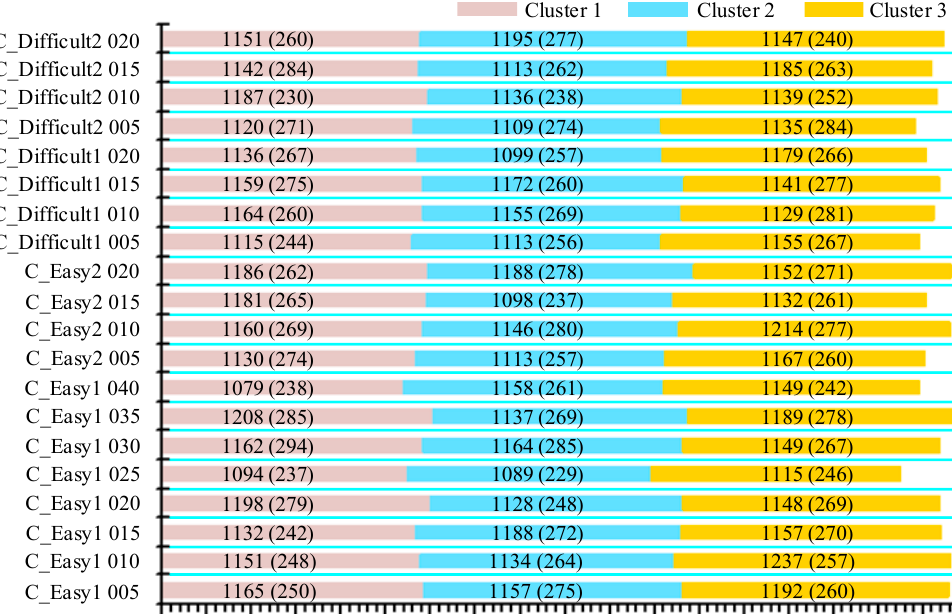
Figure 2. Details of the simulated database. Different colors represent different clusters. The number in parentheses represents the number of overlapped spikes. Brain Sci. 2020 , 10 , x FOR PEER REVIEW